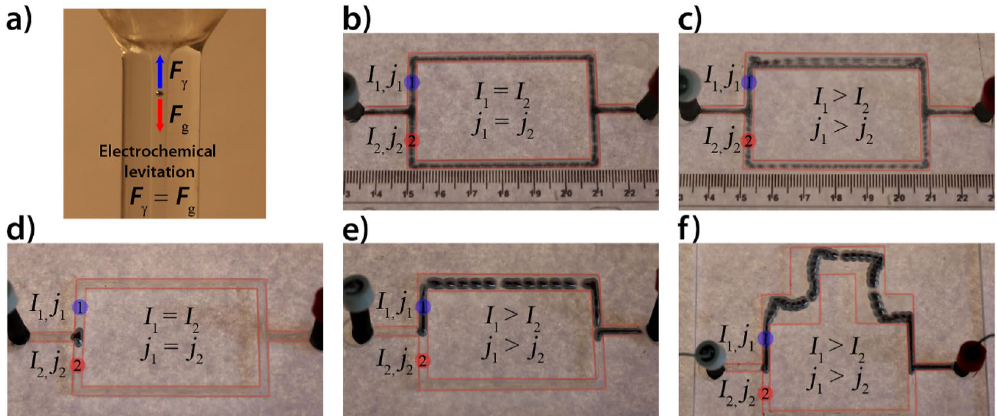
Figure 3. ( a ) Electro-levitation of a Hg droplet ( m = 6 mg) in a vertically oriented capillary tube filled with the solution of sulfuric acid ( c = 6.25 mM). The inner diameter of the capillary tube is 1.9 mm. Stochastic motion of a smaller Hg droplet ( m = 20 mg) in an electric field using the galvanostatic condition ( I = 3.0 mA) in channel networks filled with a solution of sulfuric acid ( c = 25 mM) having the same lengths ( L 1 = L 2 = 12 cm): ( b ) same widths ( w 1 = w 2 = 3 mm) and ( c ) different widths ( w 1 = 6 mm, w 2 = 3 mm). Deterministic motion of a larger Hg droplet ( m = 350 mg) in an electric field using the galvanostatic condition ( I = 3.0 mA) in channel networks having the same lengths ( L 1 = L 2 = 12 cm): ( d ) same widths ( w 1 = w 2 = 3 mm) and ( e ) different widths ( w 1 = 6 mm, w 2 = 3 mm). ( f ) The motion of the same Hg droplet in a channel network filled with a solution of sulfuric acid ( c = 25 mM) having different lengths and widths ( L 1 = 16 cm, L 2 = 12 mm, w 1 = 12 mm, w 2 = 3 mm). The depth of the solution in the channel network was ~ 4 mm. Superimposed images show the position of the droplet every 0.04